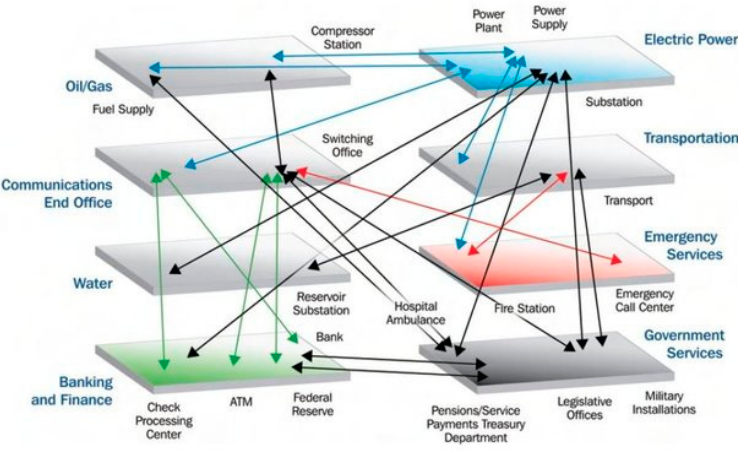
Figure 1. The interlinkages of the critical infrastructure [28].